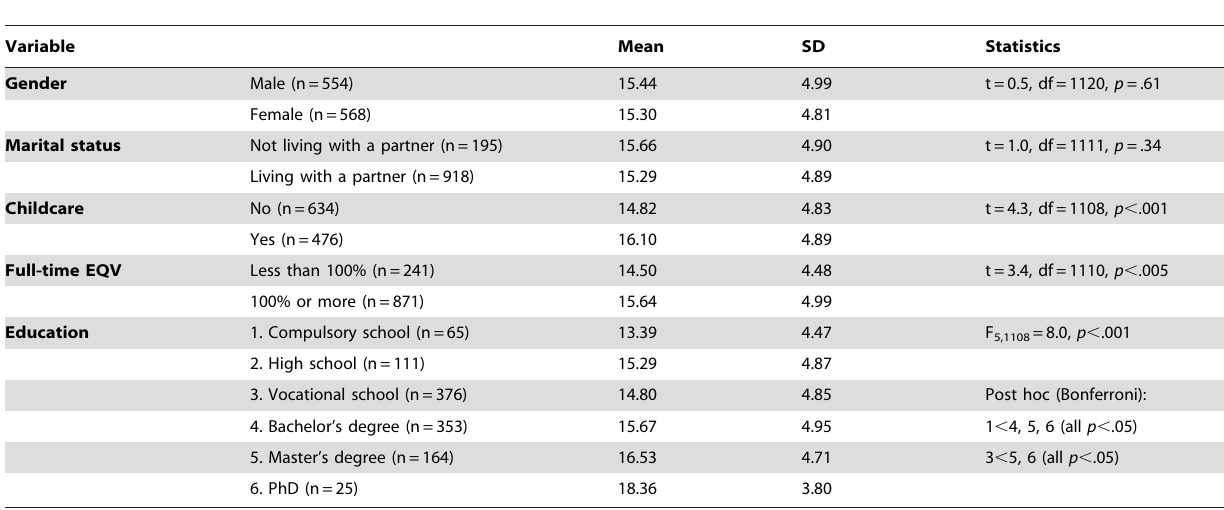
Table 5. Comparisons of mean scores of the Bergen Work Addiction Scale (BWAS) across different levels of nominal variables (gender, marital status, caretaker responsibility for children, percentage of full-time equivalent (EQV) and education) (N =1,122).